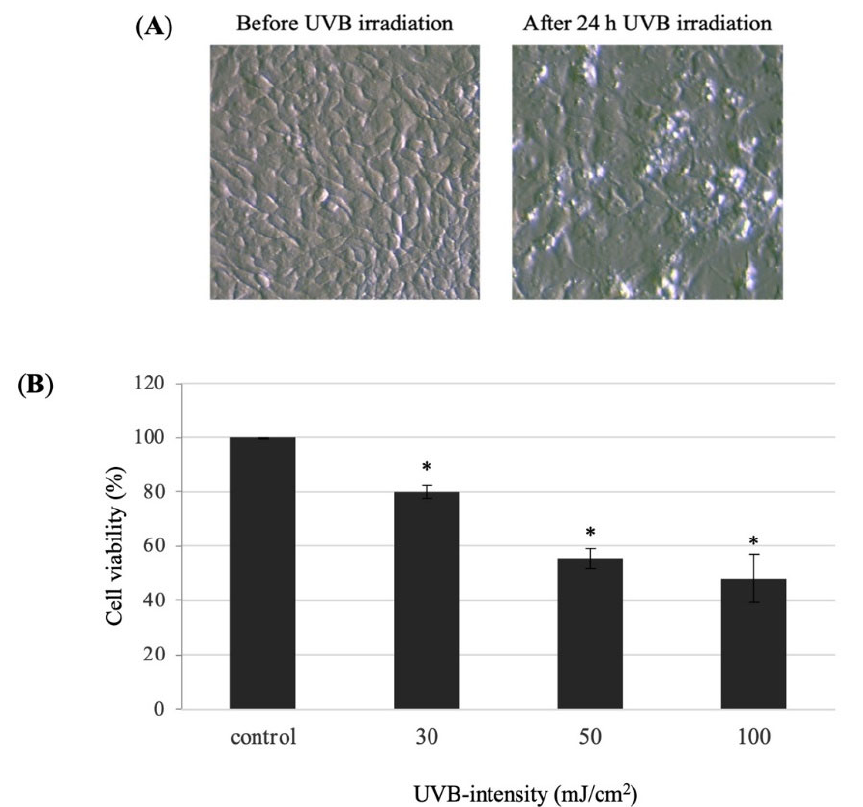
Figure 4. Effect of UVB radiation on the cell viability of HaCaT cells. ( A ) Morphology of HaCaT cells before and after 24 h UVB ‐ irradiation (30 mJ/cm 2 ). ( B ) The cell viability in the UVB ‐ irradiated HaCaT cells was performed using MTT assay. HaCaT cells (1 × 10 5 cell/well) were seeded into 96 ‐ well plate and then incubated for 24 h. The HaCaT cells were irradiated with 30, 50, and 100 mJ/cm 2 of UVB. After UVB ‐ irradiation, the HaCaT cells were incubated with DMEM serum ‐ free medium for 24 h. Values are presented as the mean ± SD of three wells.; * p < 0.01 compared with the control group.